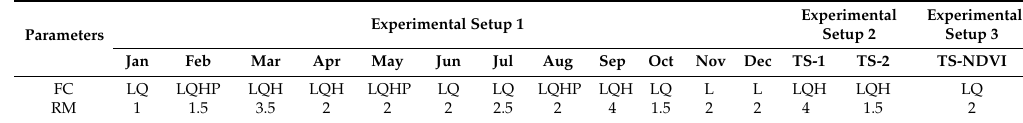
Table 5. Parameter settings of fifteen Maxent-AICc models generated by ENMeval. Note that for all Maxent-Default Parameter Set (DPS) in Maxent of Experimental Setups 1–3, the Feature Combinations (FC) were linear, quadratic and hinge, and the Regularization Multipliers (RM) was 1. L = Linear, Q = Quadratic, H = Hinge, P = Product and T =